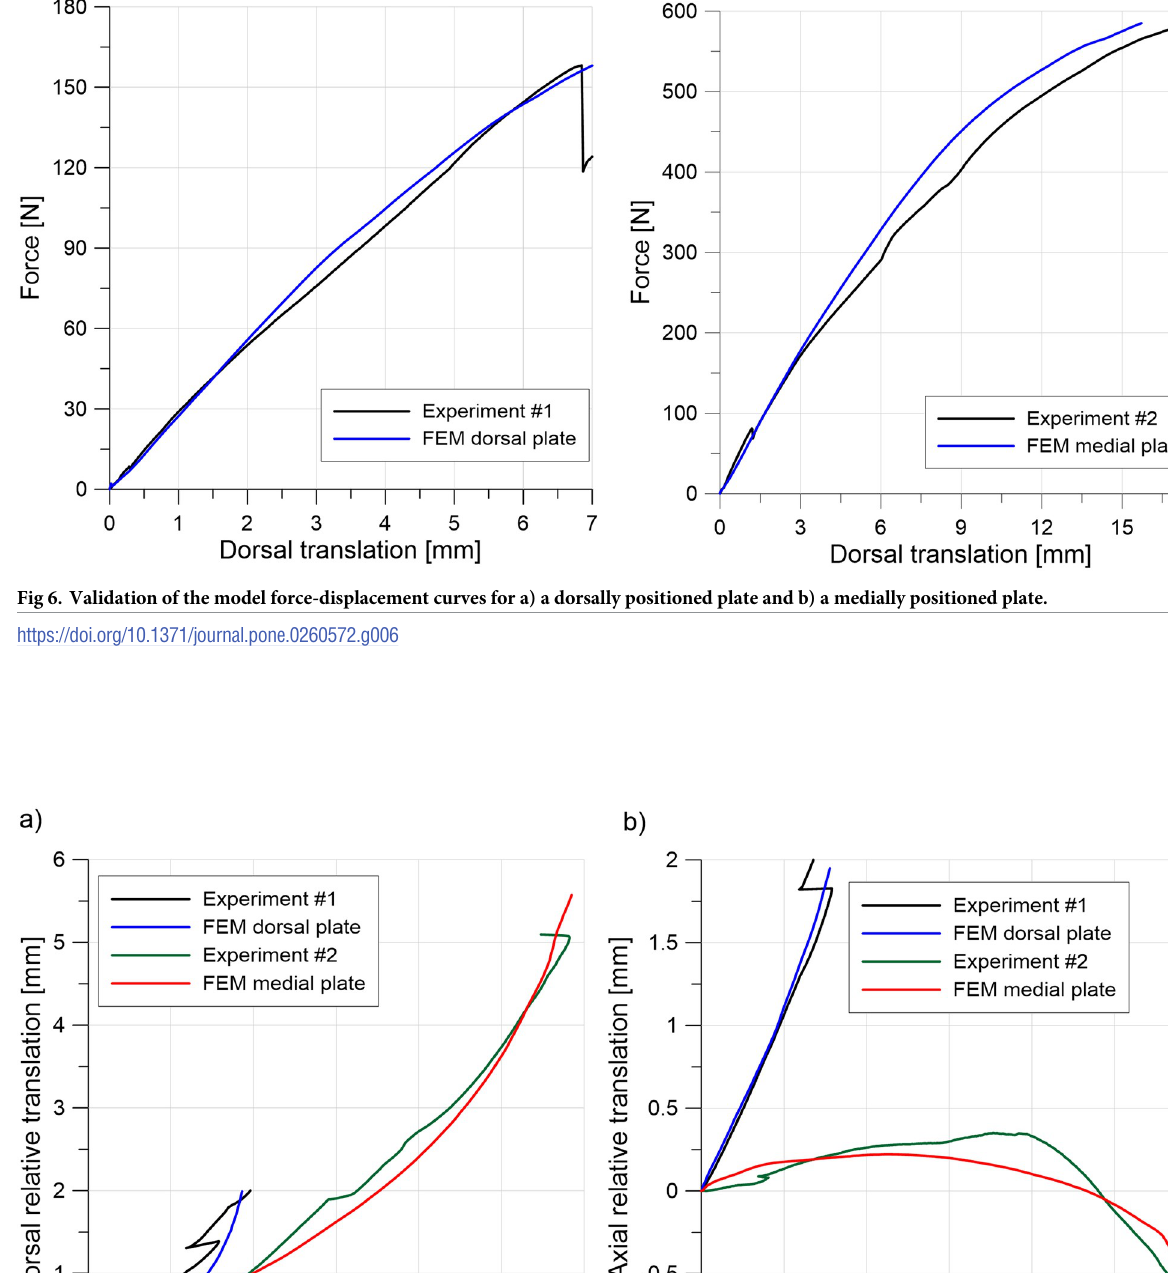
PLOS ONE | https://doi.org/10.1371/journal.pone.0260572 December1, 2021 9 /